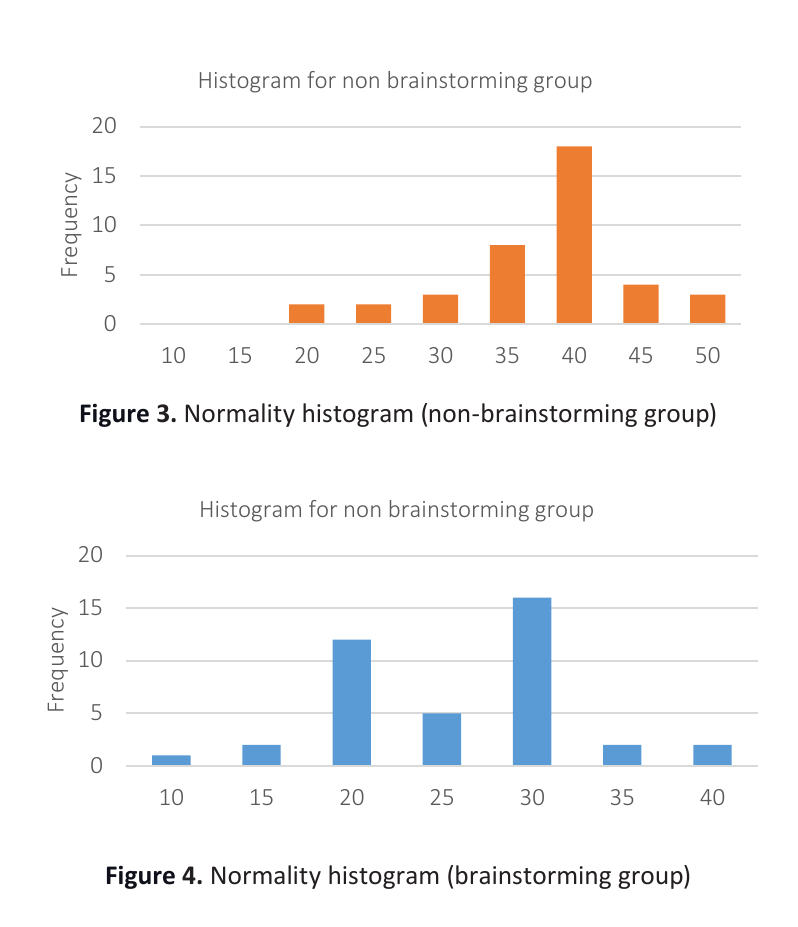
Figure 2. Normal line graph (brainstorming group)